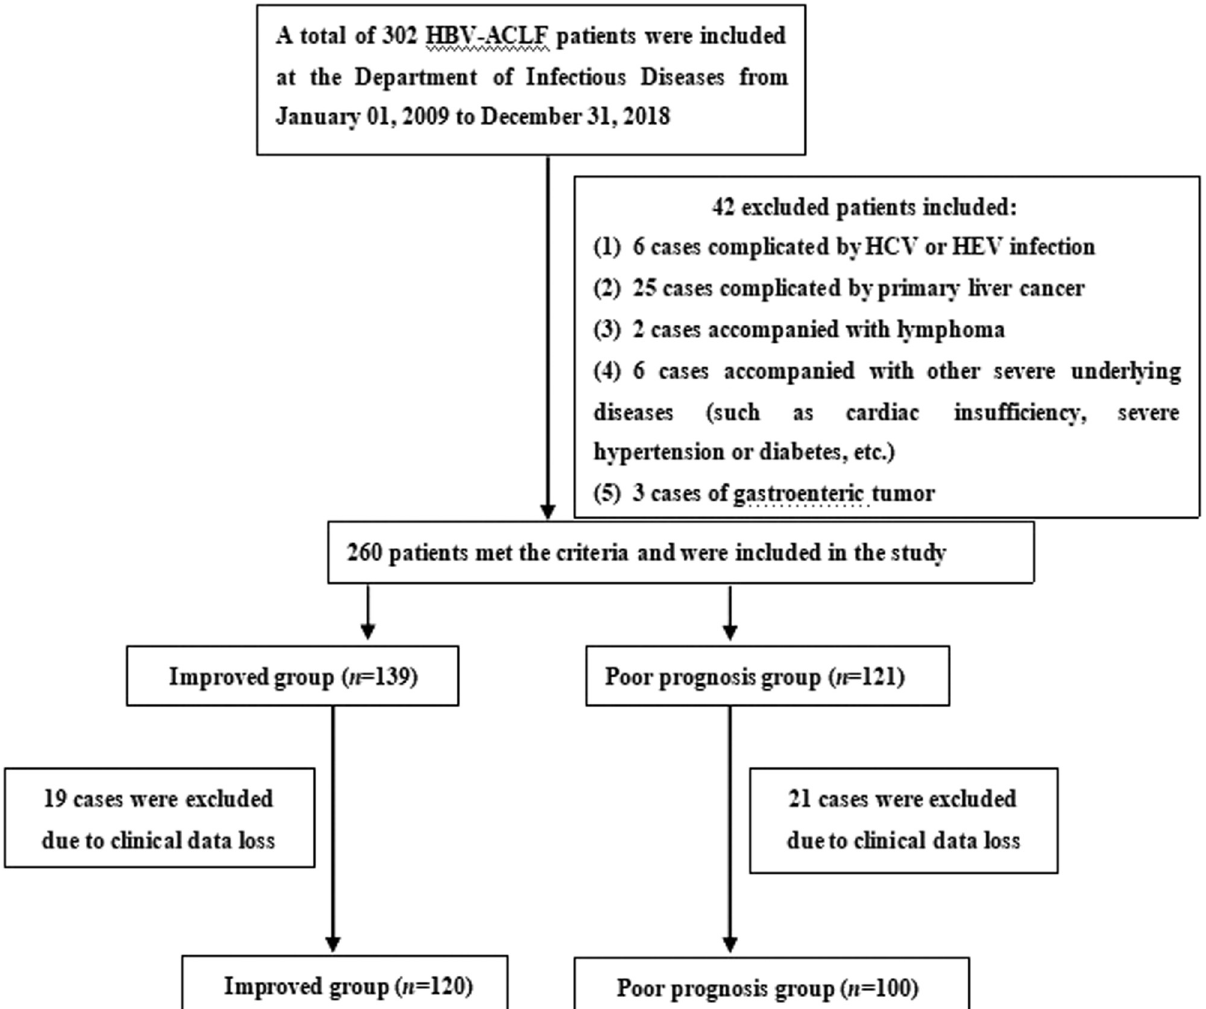
Figure 1: Case screening and registration. There was no statistical di ff erence in the disease stage at admission between the poor prognosis group and the good prognosis group.